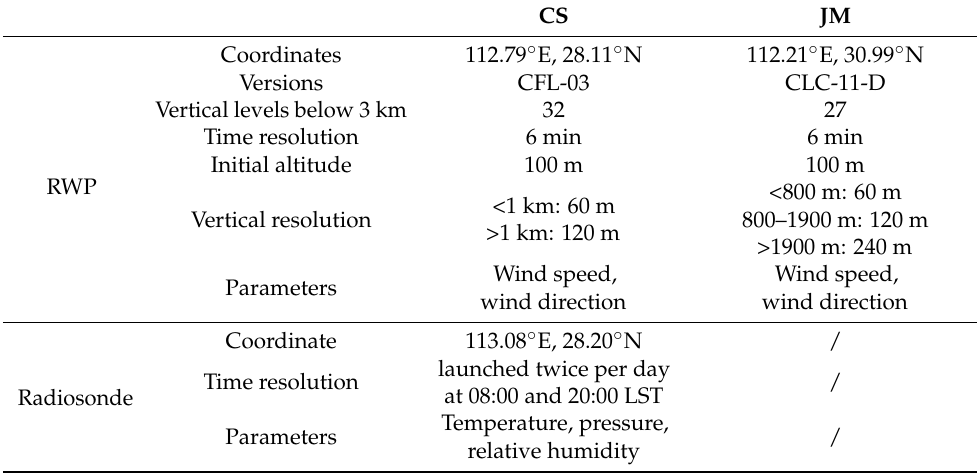
Table 1. Detailed information on RWPs and radiosonde measurements in CS and JM.